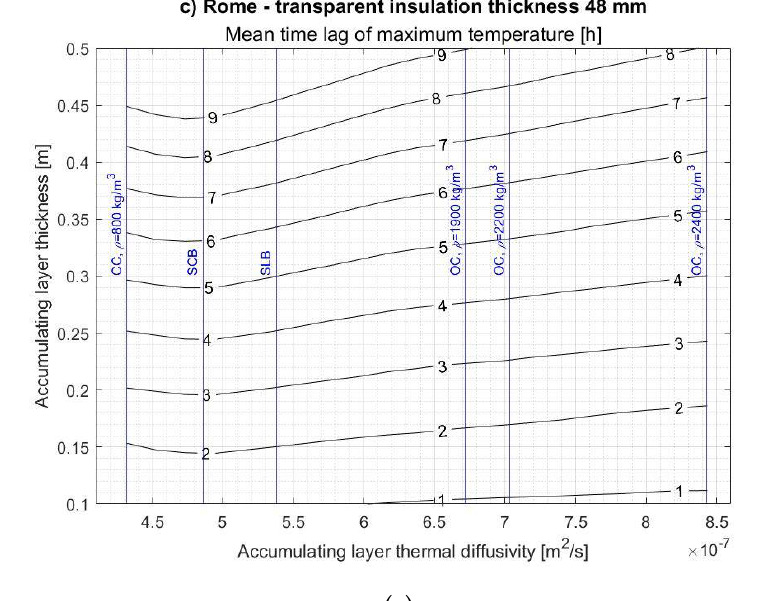
Figure A10. Cont